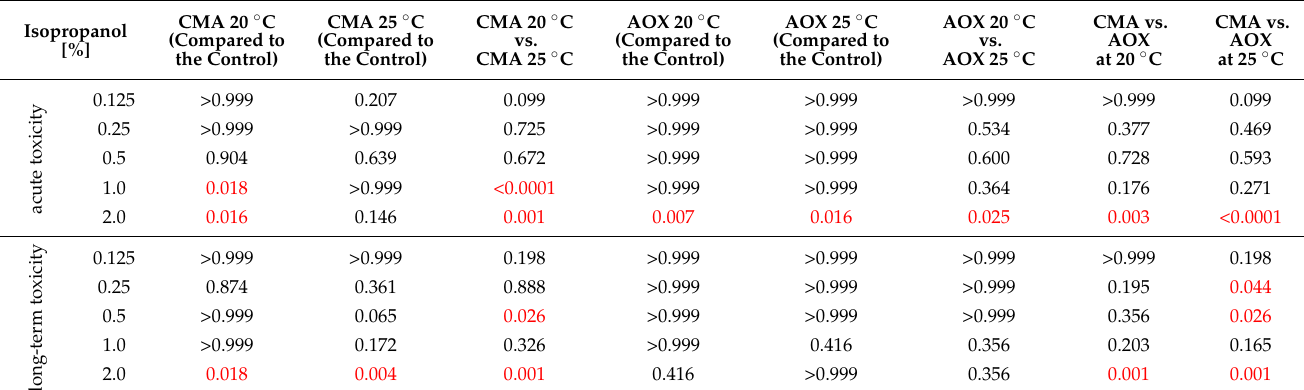
Table 2. Statistical evaluation of percentage mortality rates due to increasing isopropanol concentrations in intra- and interspecies comparison of Atlantic sturgeon (AOXlar7y, AOX) and maraena whitefish (CMAfin1, CMA) at cultivation temperatures 20 and 25 ◦ C. Significant different p values (<0.05) highlighted in red.